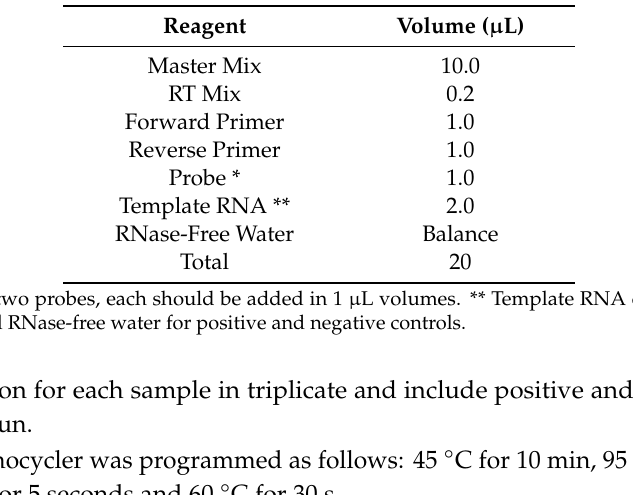
Table 2. Volumes of reagents added to each RT-qPCR